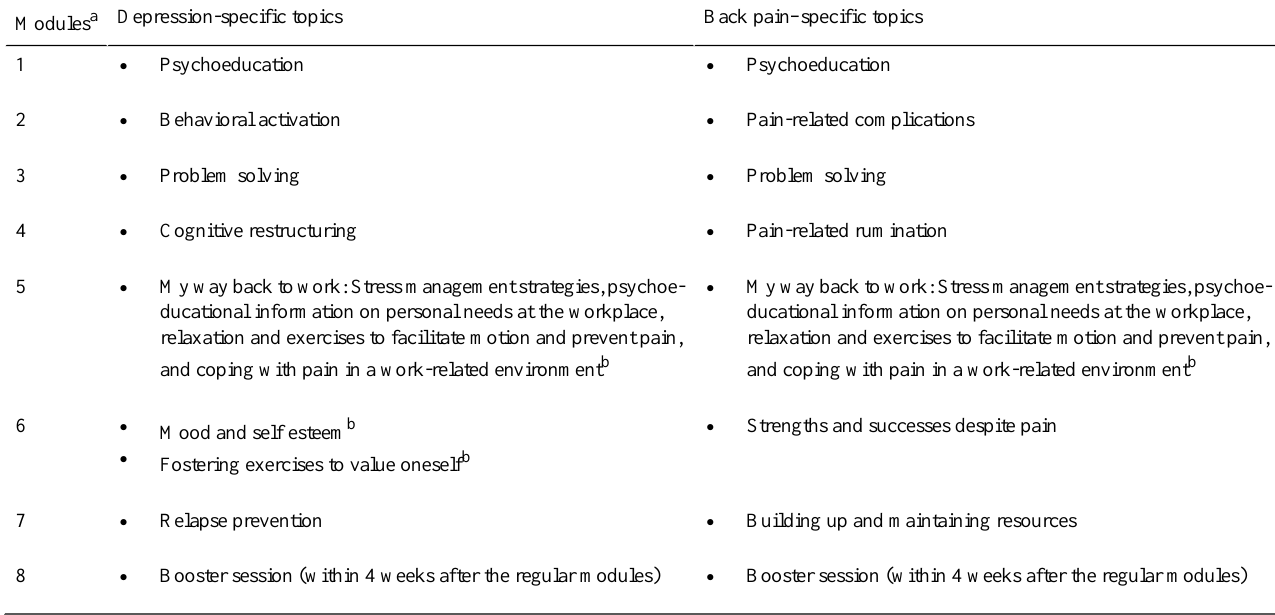
Table 1. Content of the Get.Back intervention and changes from eSano